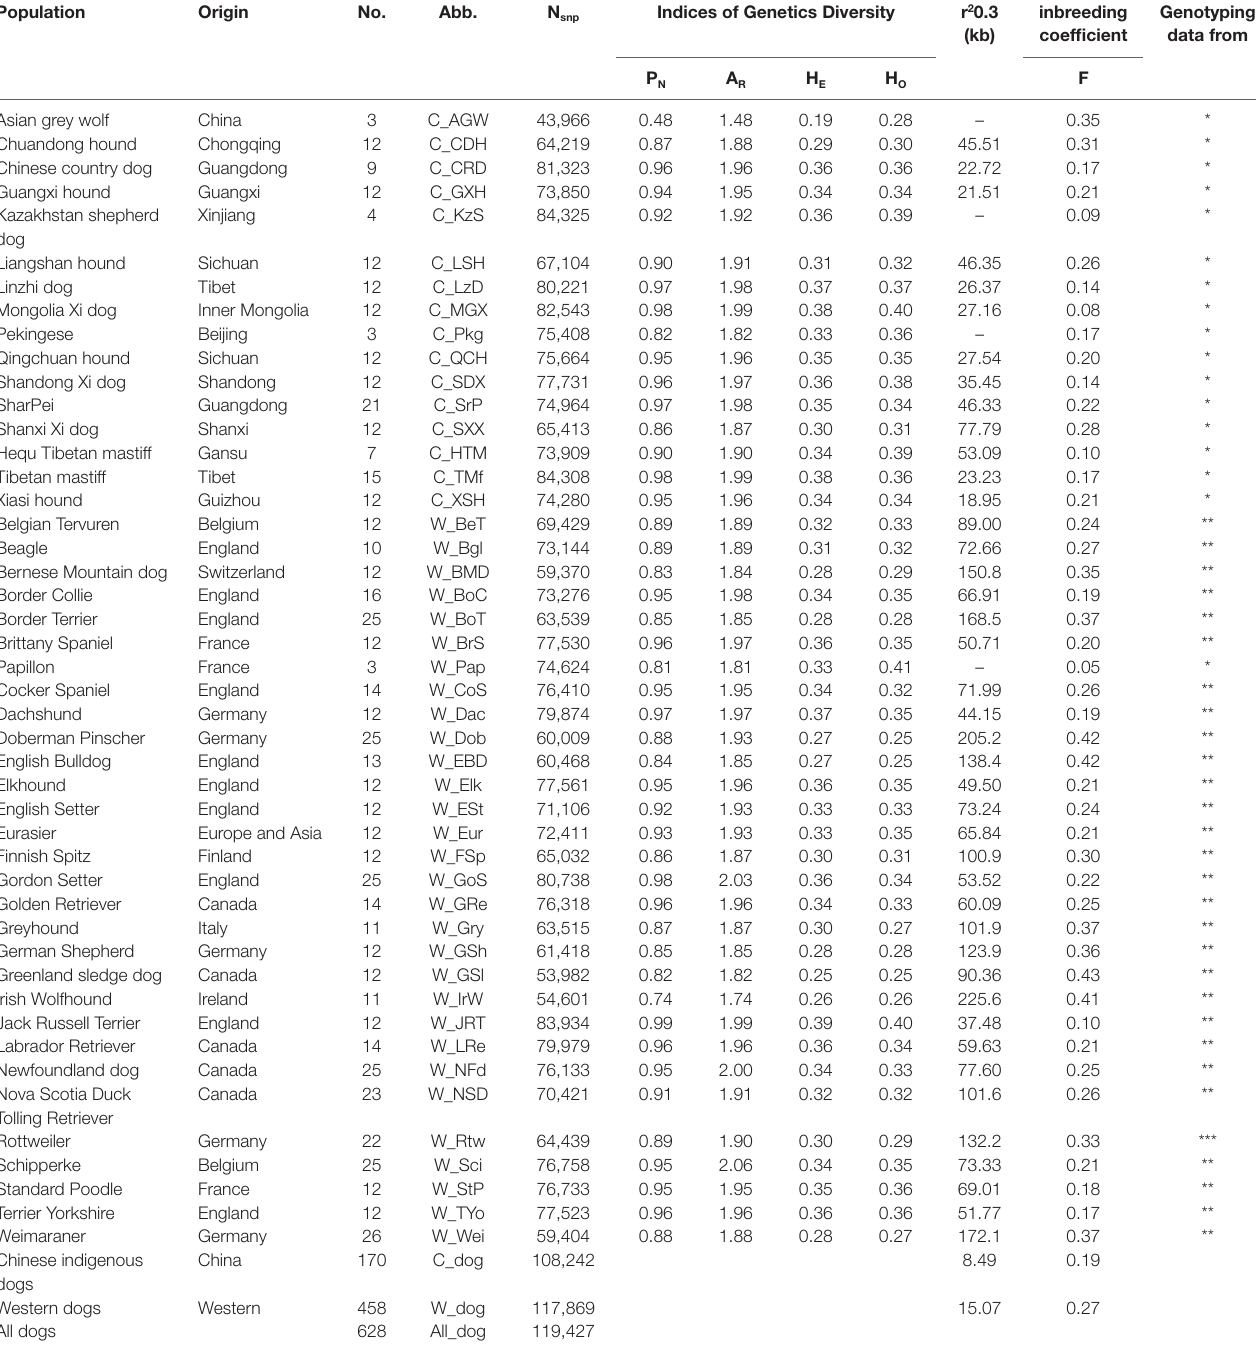
No. indicates the number of individual for each breed; Abb. represents the breed abbreviation that used in this article; N SNP , the number of SNPs with MAF >0.1; P N , the proportion of the SNPs which displayed polymorphism in each dog breed in the all 131,927 SNPs passed the quality control; A R , allelic richness; H E , expected heterozygosity; H O , observed heterozygosity; r 2 0.3 were calculated between all pairs of SNPs with MAF ≥5% and <10% missing data in each population. *Genotyping data from this study, and **from Vaysse et al. (2011). ***10 samples of Rottweiler were collected from service dog station in Nanchang, Jiangxi province, and genotyped in this distance (D ) between populations using PLINK (v1.9). Genetic st distance between all pairwise combinations of individuals was calculated as 1-Dst.